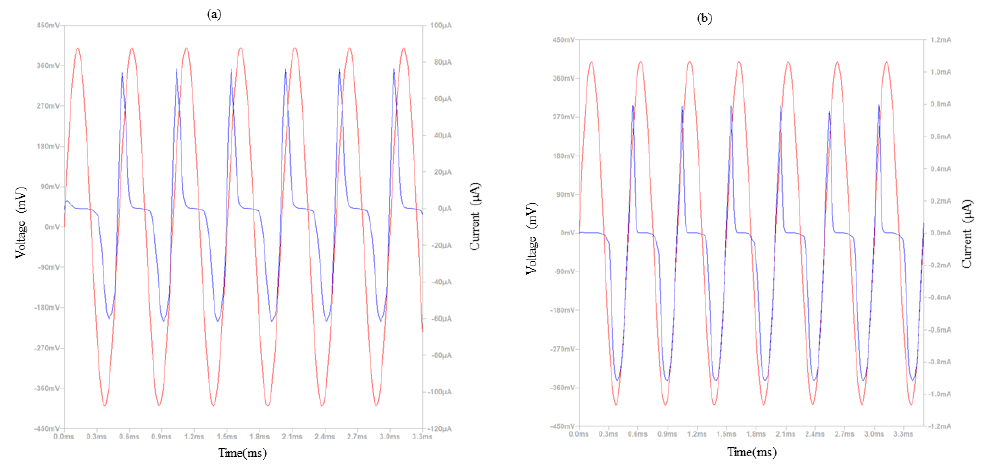
Figure 4. Transient response of the proposed memristor emulator: ( a ) 16 nm and ( b ) 45 nm.